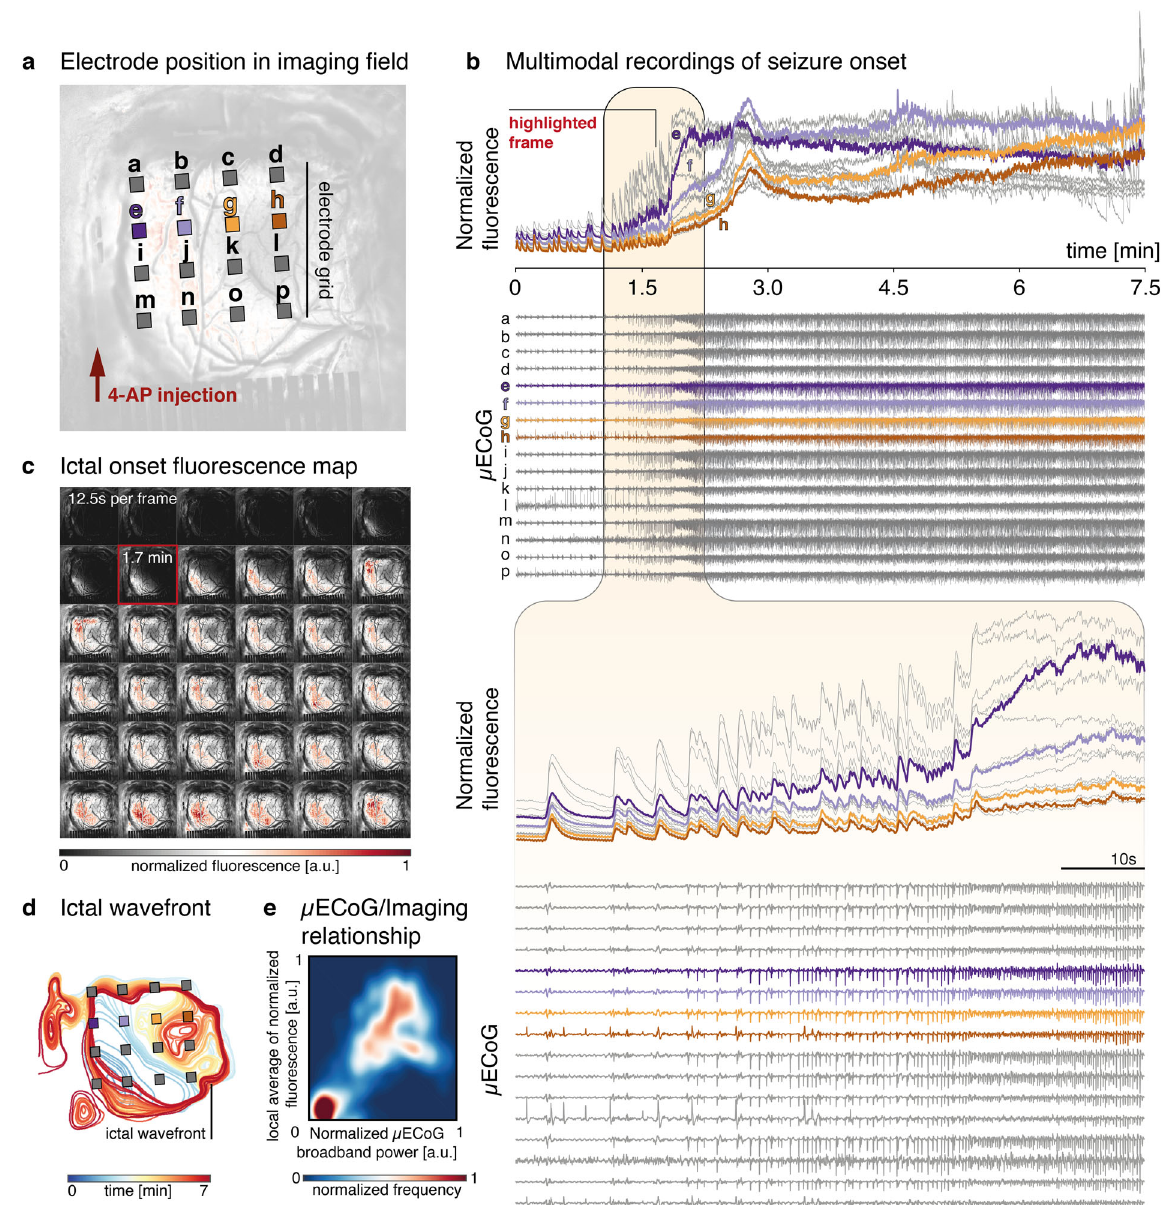
Fig. 3 Concurrent multimodal data obtained during a single seizure onset. a Relative positions of the graphene contacts on the cortex (individual electrodes not shown to scale) and the location of 4-AP drug application. Electrodes labeled e, f, g, and h are highlighted and shown as example data. b Fluorescence intensity (normalized to baseline mean and variance) beneath each individual electrode and simultaneous µ ECoG recordings from the graphene array. The period of acute seizure onset is magni fi ed in the bottom panel. c Series of image frames corresponding to the seizure onset shown in b . From the full image sampling resolution of 10 Hz, frames are sampled here for visualization only every 12.5 s (0.08 Hz), illustrating the entire progression of seizure onset and propagation. d Ictal wavefront evolution over time for the seizure shown in b . Note particularly the early recruitment of channel e and the comparatively late recruitment of channel h. e Density plot indicating the signi fi cant relationship (Pearson ’ s correlation coef fi cient r = 0.71, p < 0.001 for the linear fi t) between µ ECoG broadband power and local calcium fl uorescence averages. The colormap indicates the density, or normalized observed frequency of values distributed along the two dimensions ( µ ECoG broadband power, calcium fl